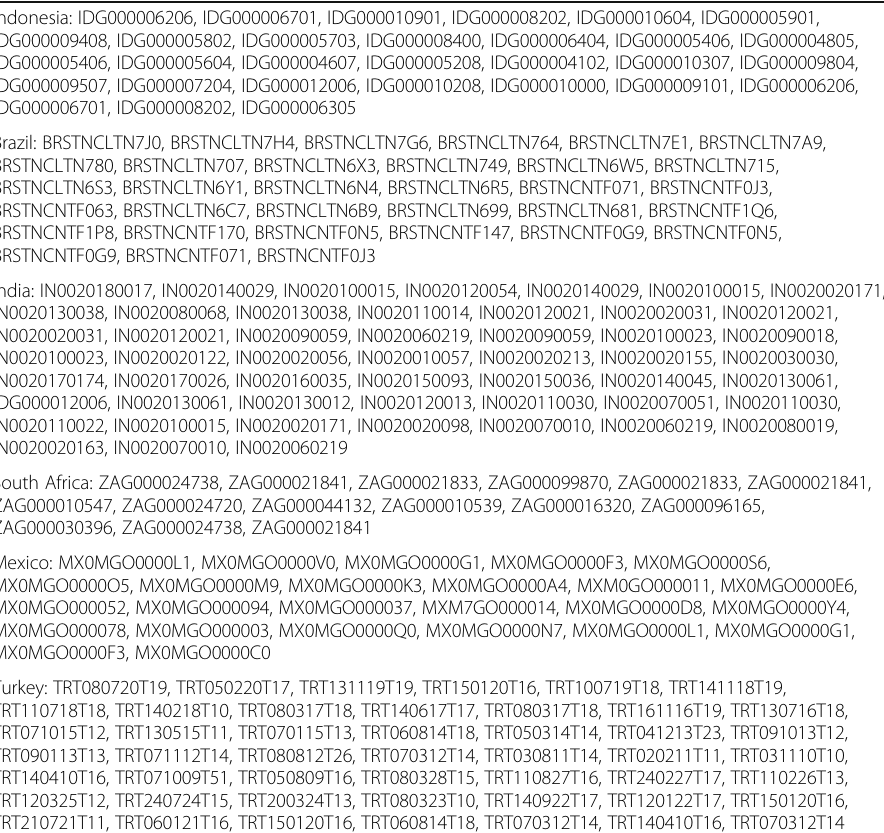
Table 9 ISIN codes of the